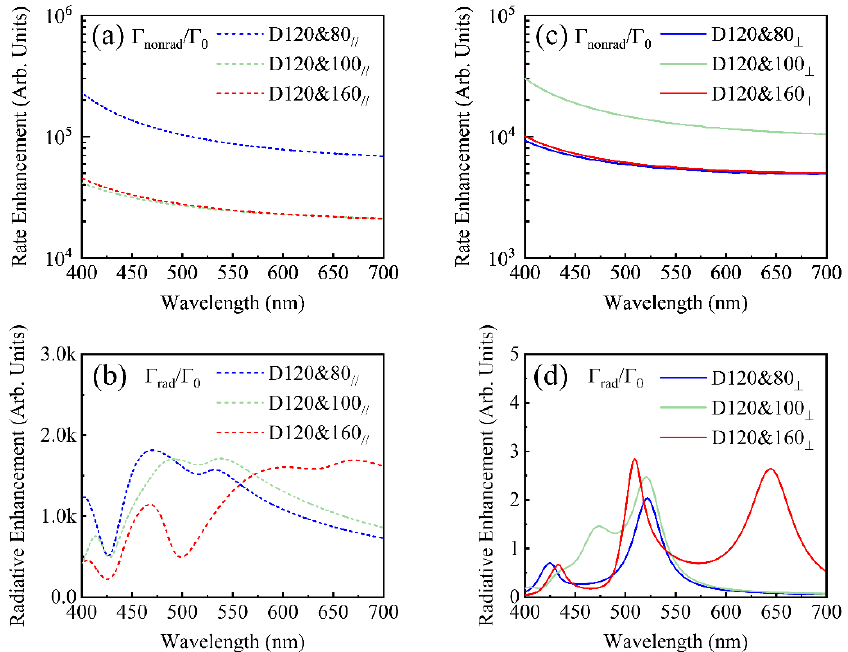
Figure 7. ( a , c ) nonradiative and ( b , d ) radiative rate enhancements of silicon dimers as a function of emission wavelength under longitudinal and transverse excitation.